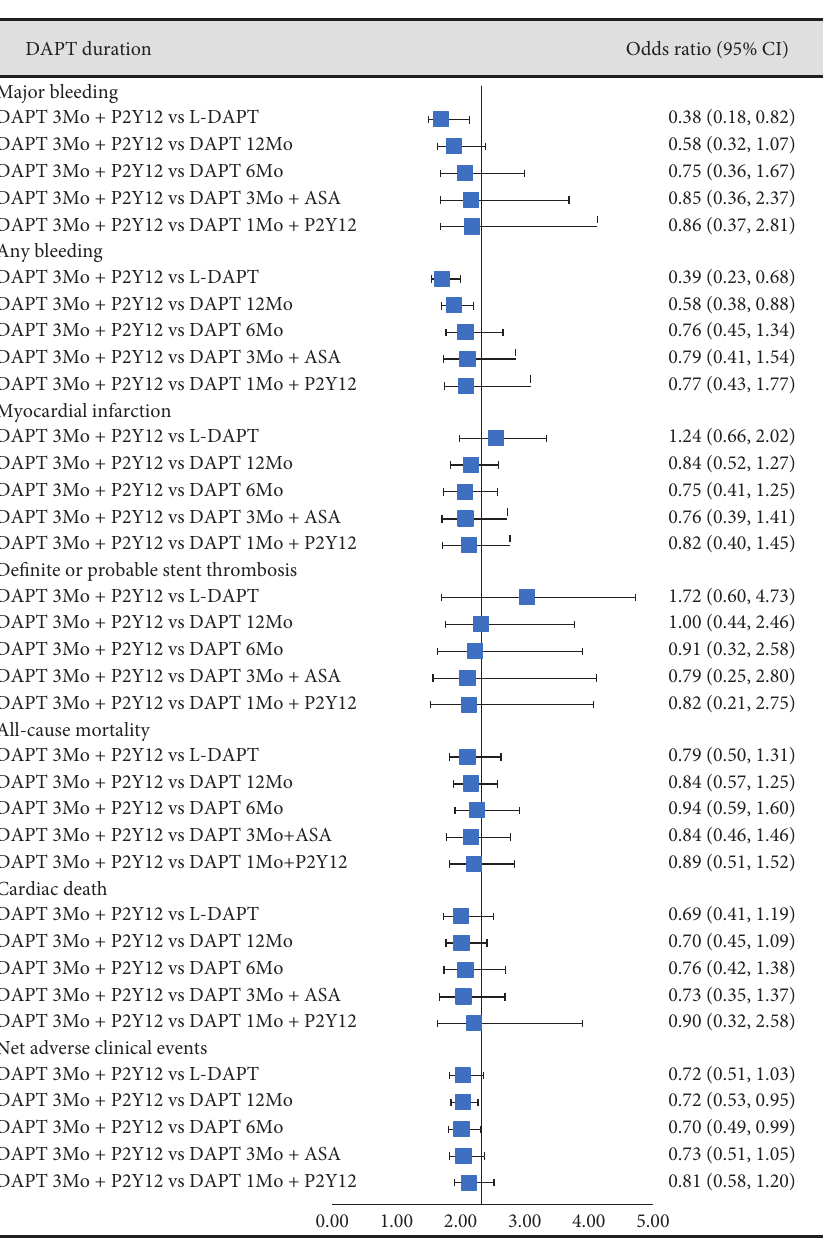
Figure 3: Forest plots. L-DAPTrefers to longer-term ( > 12 months) DAPT, DAPT12Mo refers to 12-month DAPT, DAPT 6Mo refers to 6- month DAPT, DAPT 3Mo+ASA refers to 3-month DAPTfollowed by aspirin monotherapy, DAPT 3Mo +P2Y12 refers to 3-month DAPT followed by P2Y12 receptor inhibitor monotherapy, and DAPT1Mo+ P2Y12 refers to 1-month DAPTfollowed by P2Y12 receptor inhibitor monotherapy. DAPT indicates dual antiplatelet